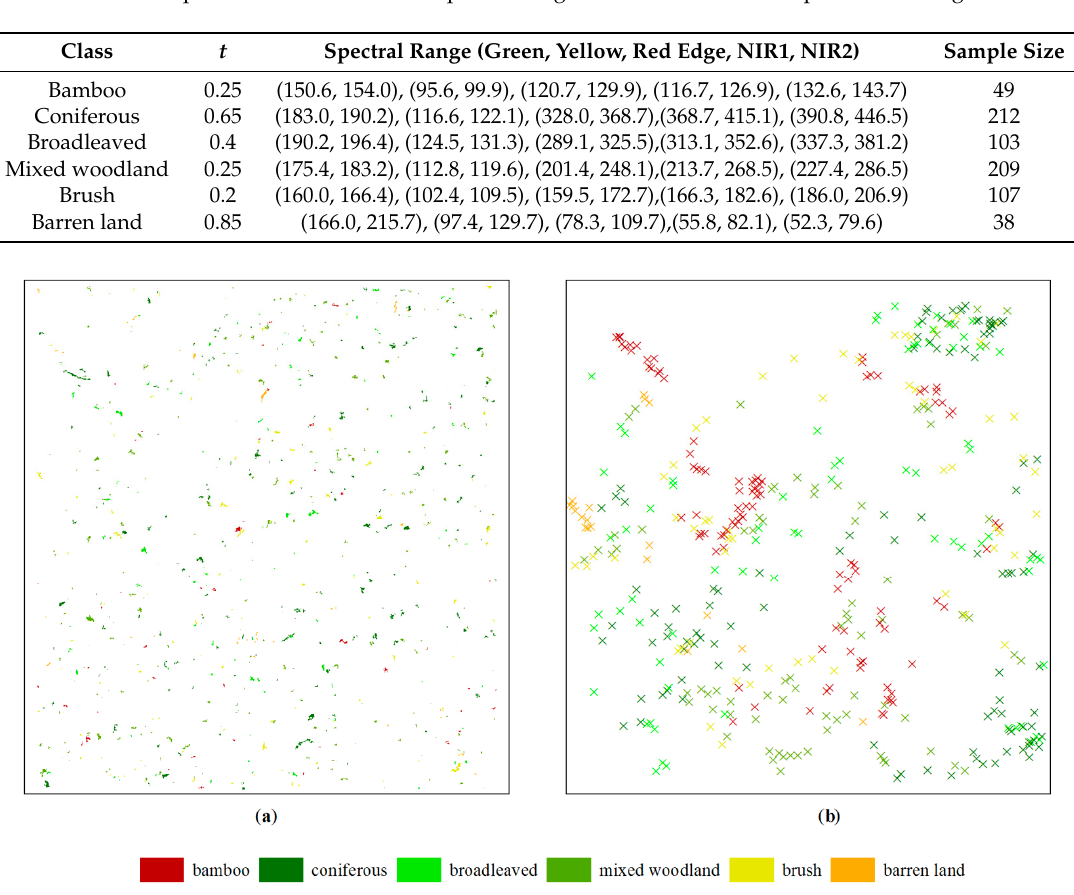
Figure 5. Spatial distribution of the samples: ( a ) training data and ( b ) testing data.